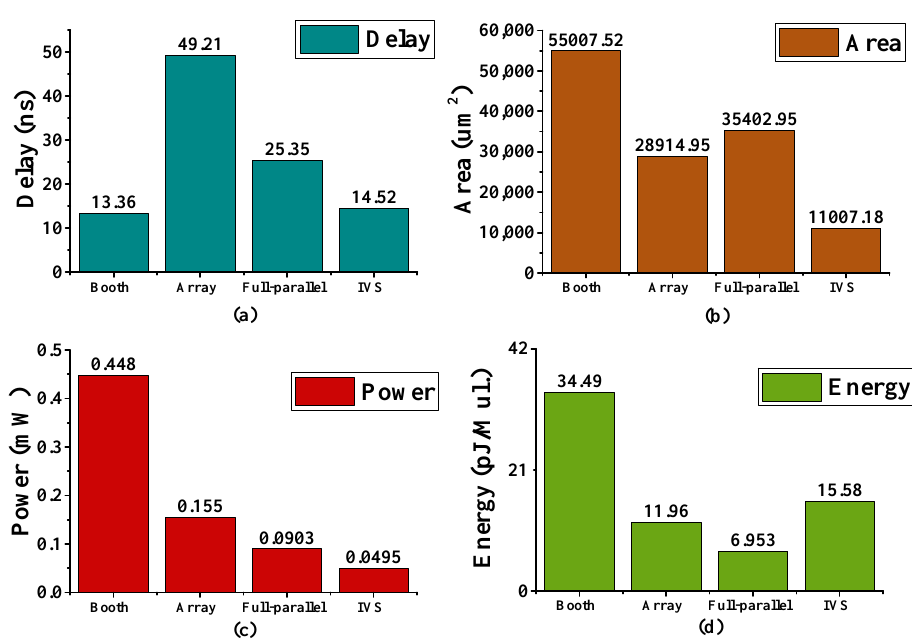
Figure 8. Comparisons in bar graphs. ( a ) Delay. ( b ) Area. ( c ) Power. ( d ) Energy.